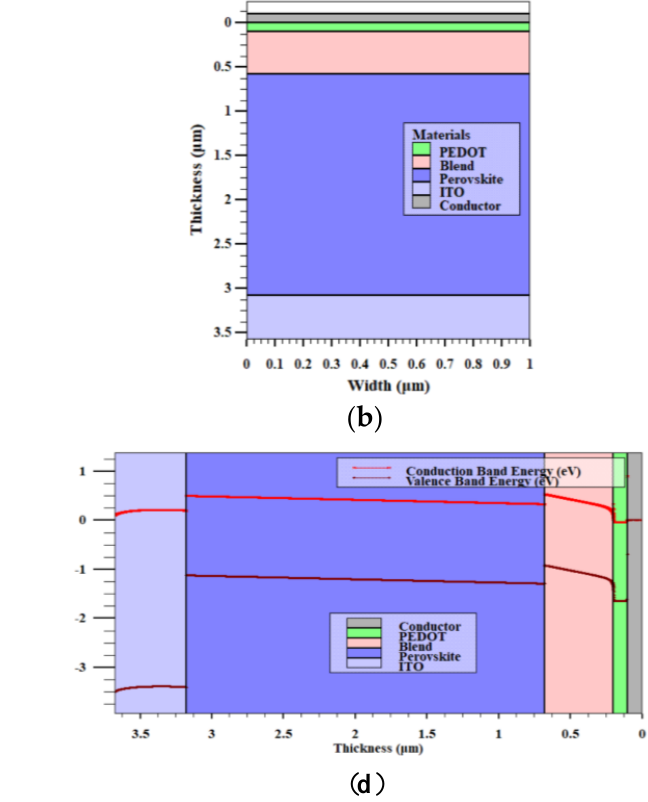
Figure 1. Basic structure and energy levels of the proposed narrowband near-infrared perovskite/or- ganic photodetector. ( a ) Schematic illustration of the structure of PDs, ( b ) generated structure from the device simulator, ( c ) energy level diagram of the different layers, and ( d ) energy band diagram at dark condition showing conduction and valence edges.